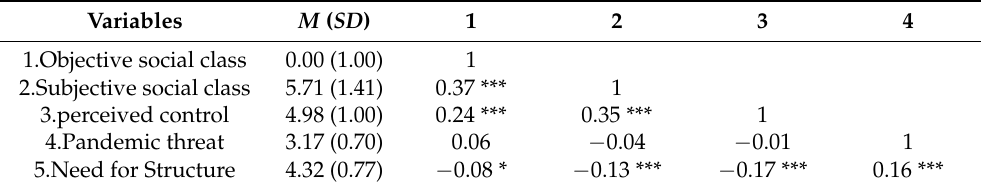
Table 1. Descriptive statistics and correlations for all